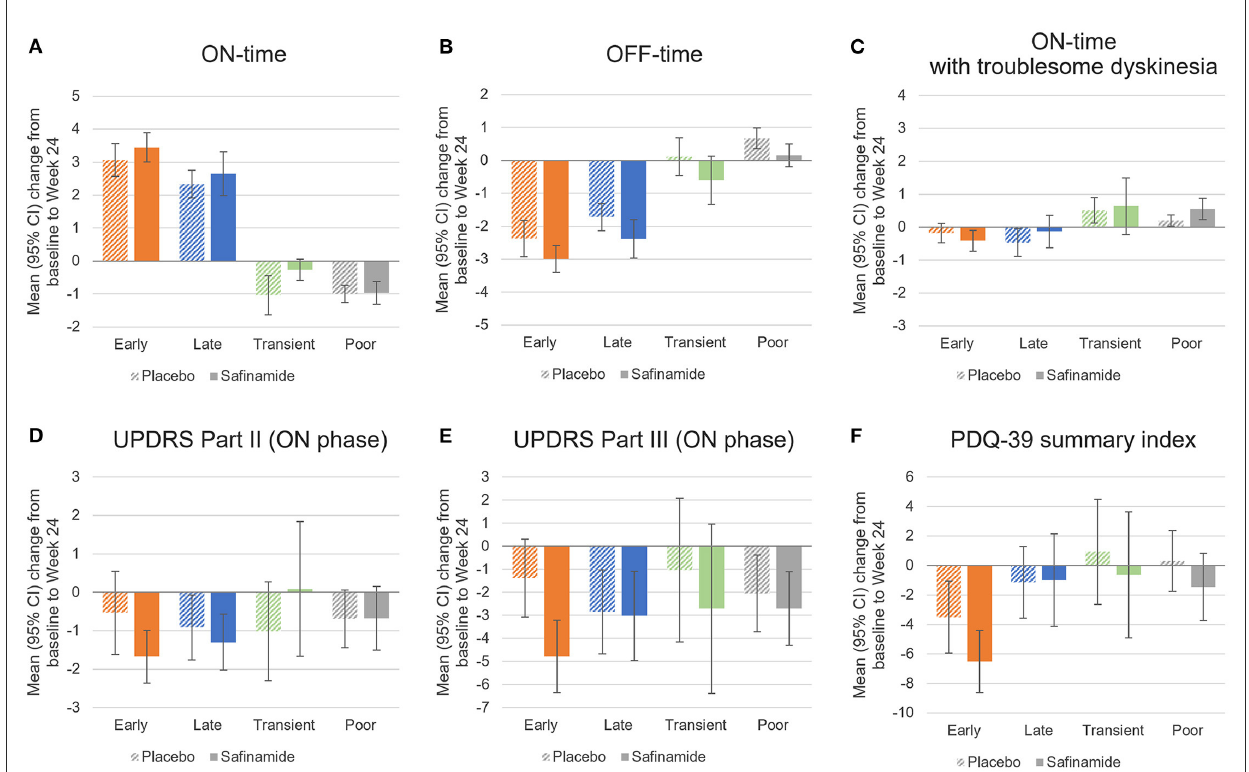
FIGURE3 Changes from baseline to Week 24 in diary outcomes (A–C) , UPDRS scores (D, E) , and the PDQ-39 summary index (F) by responder subgroup in the placebo and safinamide groups. 95%CI, 95% confidence interval; PDQ-39, 39-item Parkinson’s Disease Questionnaire; UPDRS, Unified Parkinson’s Disease Rating